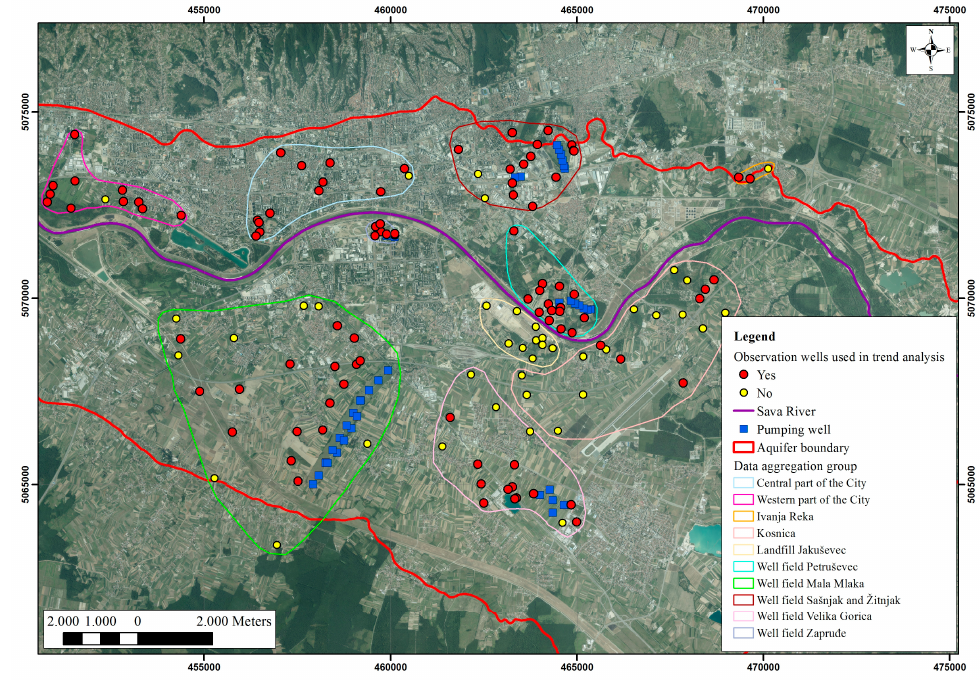
Figure 2. Observation wells used in trend analysis.